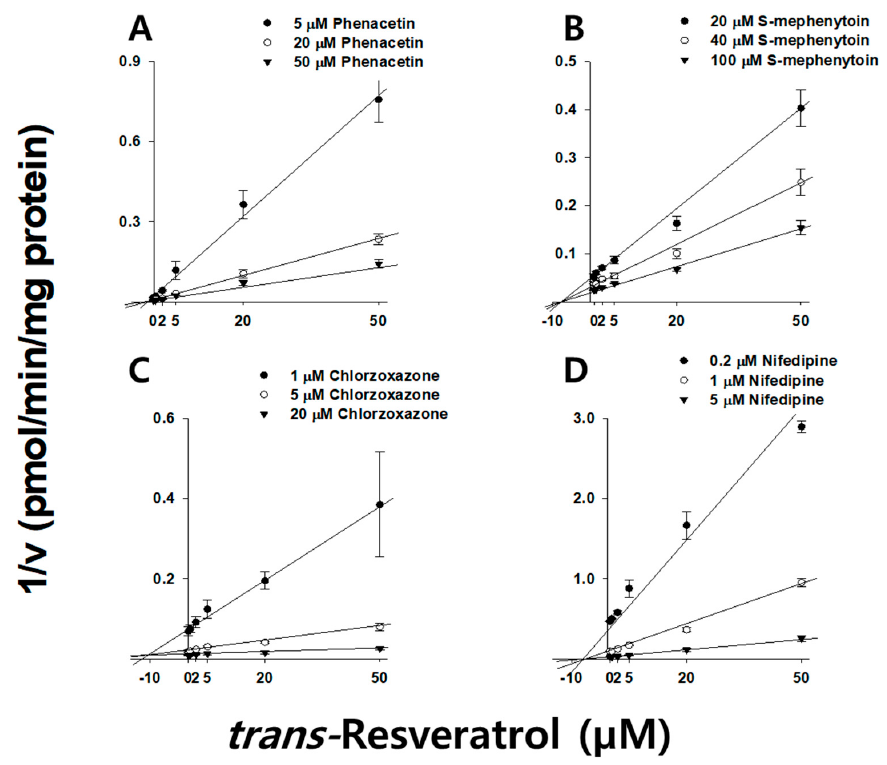
Figure 3. Representative Dixon plots obtained from inhibition kinetic studies of CYP1A2-mediated phenacetin O -deethylation ( A ); CYP2C19-mediated S -mephenytoin 4-hydroxylation ( B ); CYP2E1-mediated chlorzoxazone 6-hydroxylation ( C ), and CYP3A-mediated nifedipine dehydrogenation ( D ) in the presence of different concentrations of trans -resveratrol in pooled human liver microsomes ( n = 3). Each trans -resveratrol (0, 0.5, 2.0, 5.0, 20, and 50 μ M) was pre-incubated with HLMs in the presence of an NADPH-generating system (30 min, 37 °C), and then an increasing concentration of phenacetin (5 ( ), 20 ( ), and 50 μ M ( )), S -mephenytoin (20 ( ), 40 ( ), and 100 μ M ( )), chlorzoxazone (1 ( ), 5 ( ), and 20 μ M ( )), and nifedipine (0.2 ( ), 1 ( ), and 5 μ M ( )) was added prior to further incubation for 10 min.